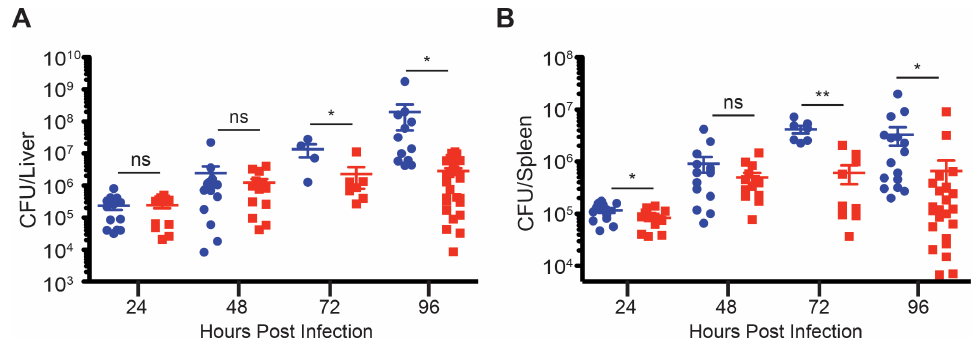
Fig 4. fGR1 mice are more resistant to L . monocytogenes infection. WT C57Bl/6(blue) and fGR1 (red) mice were infected intravenously with 1.0 x 10 4 CFUs of L . monocytogenes . Bacterial burdenswere determined in both the A) liver and B) spleen at 24, 48, 72 and 96 hpi. (All time points are pooledfrom at least 3 independent experiments, 3–5 mice per group per experiment, * Two-Tailed